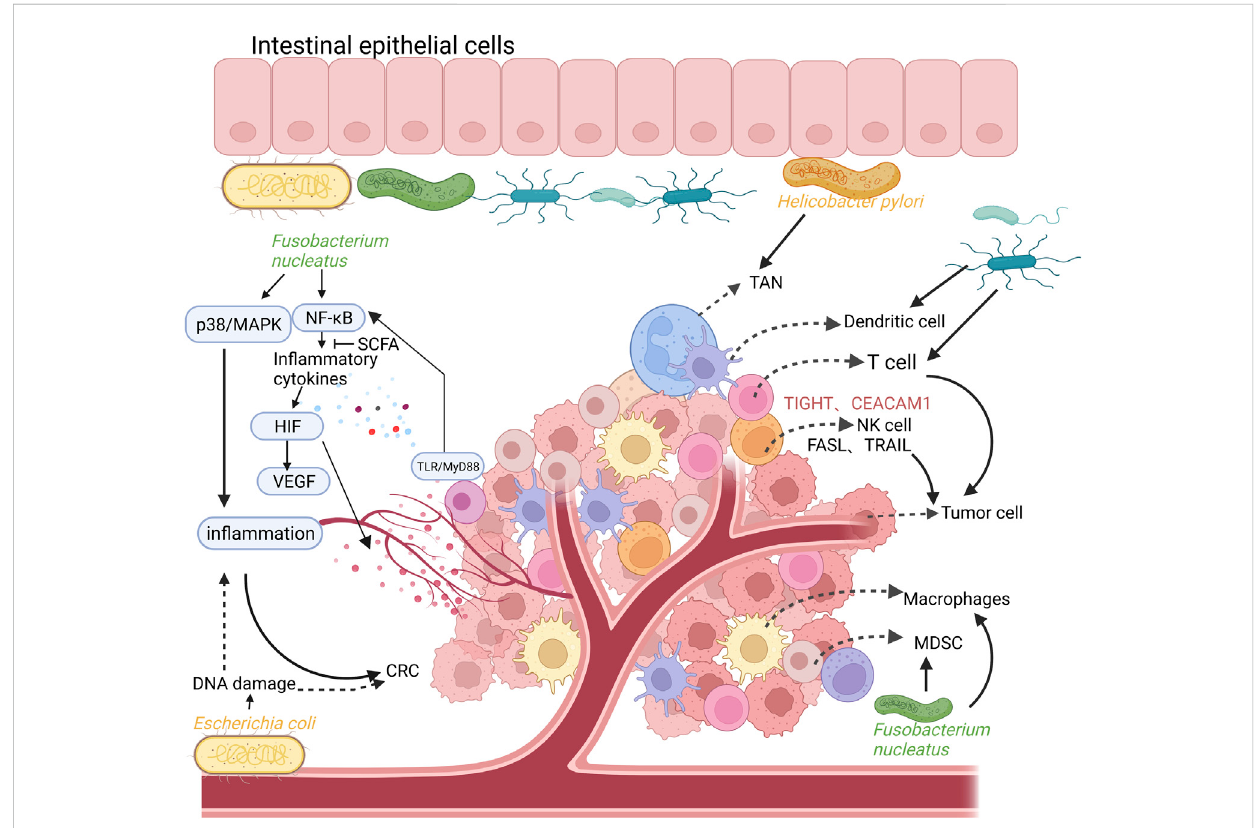
FIGURE 1 The relationship between intestinal fl ora, in fl ammation, colorectal cancer (CRC), and the composition of the tumor immune microenvironment. Intestinal commensal bacteria (such as Fusobacterium nucleatum ) promote the activation of NF- κ B and the expression of pro-in fl ammatory cytokines through TLR/MyD88 signaling on tumor-in fi ltrating cells, which can directly regulate the HIF pathway and promote the expression of VEGF, leading to angiogenesisintumortissues. Inaddition, Fusobacteriumnucleatum canalso promotep38orMAPK signal-mediatedpro-in fl ammatoryresponses, promoting the formation of CRC. Polyketide synthase-expressing (pks+) Escherichia coli can aggravate colon in fl ammation and malignant cell transformation by destroying the DNA of colon cells. The tumor immune microenvironment is mainly composed of T cells,